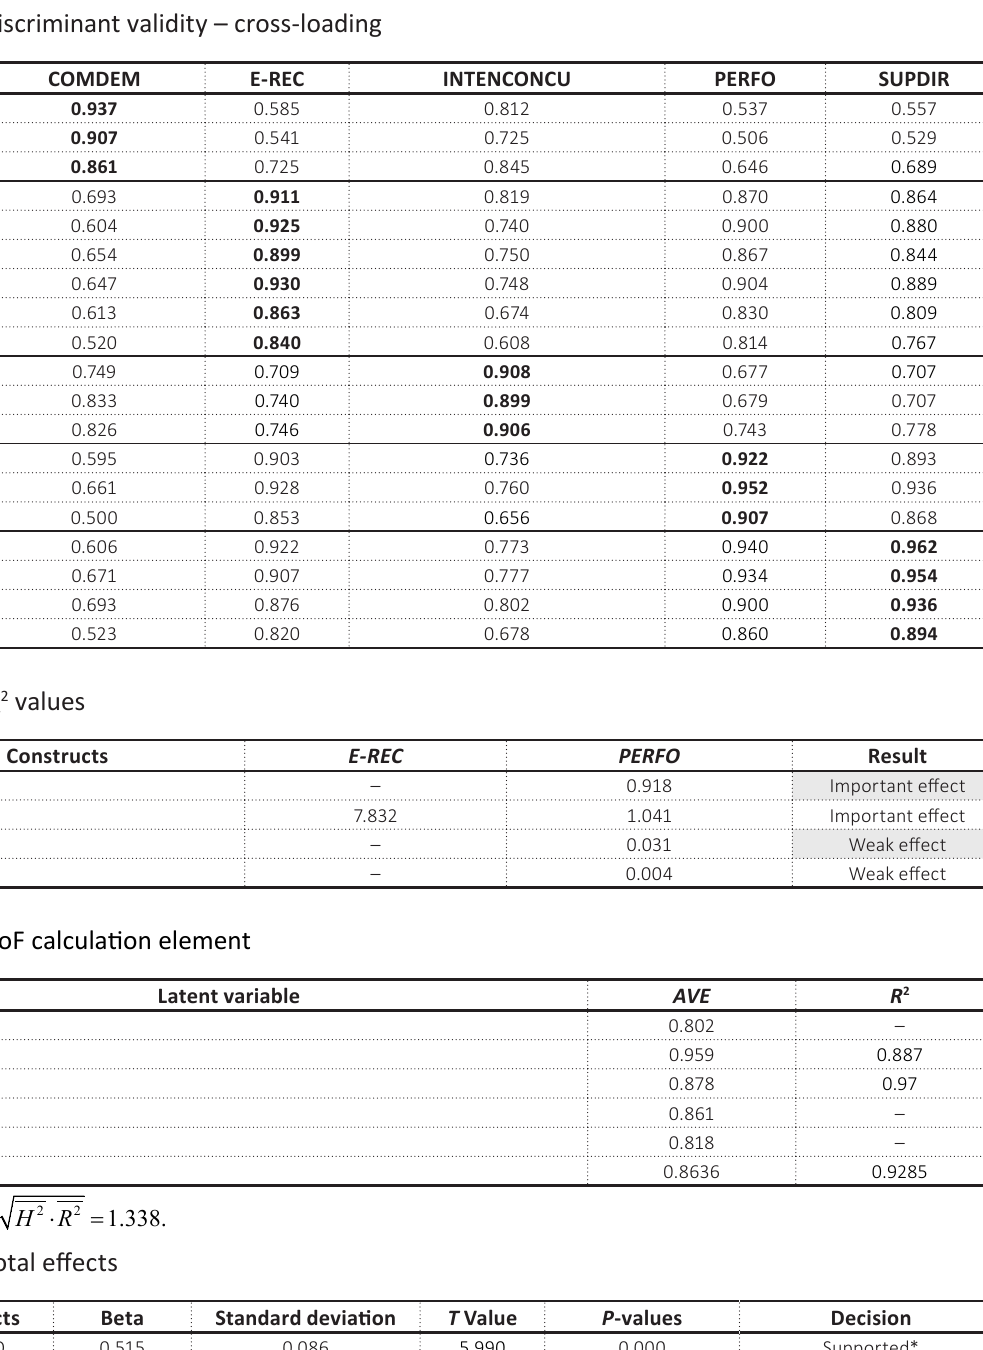
Table B1. Discriminant validity – cross-loading